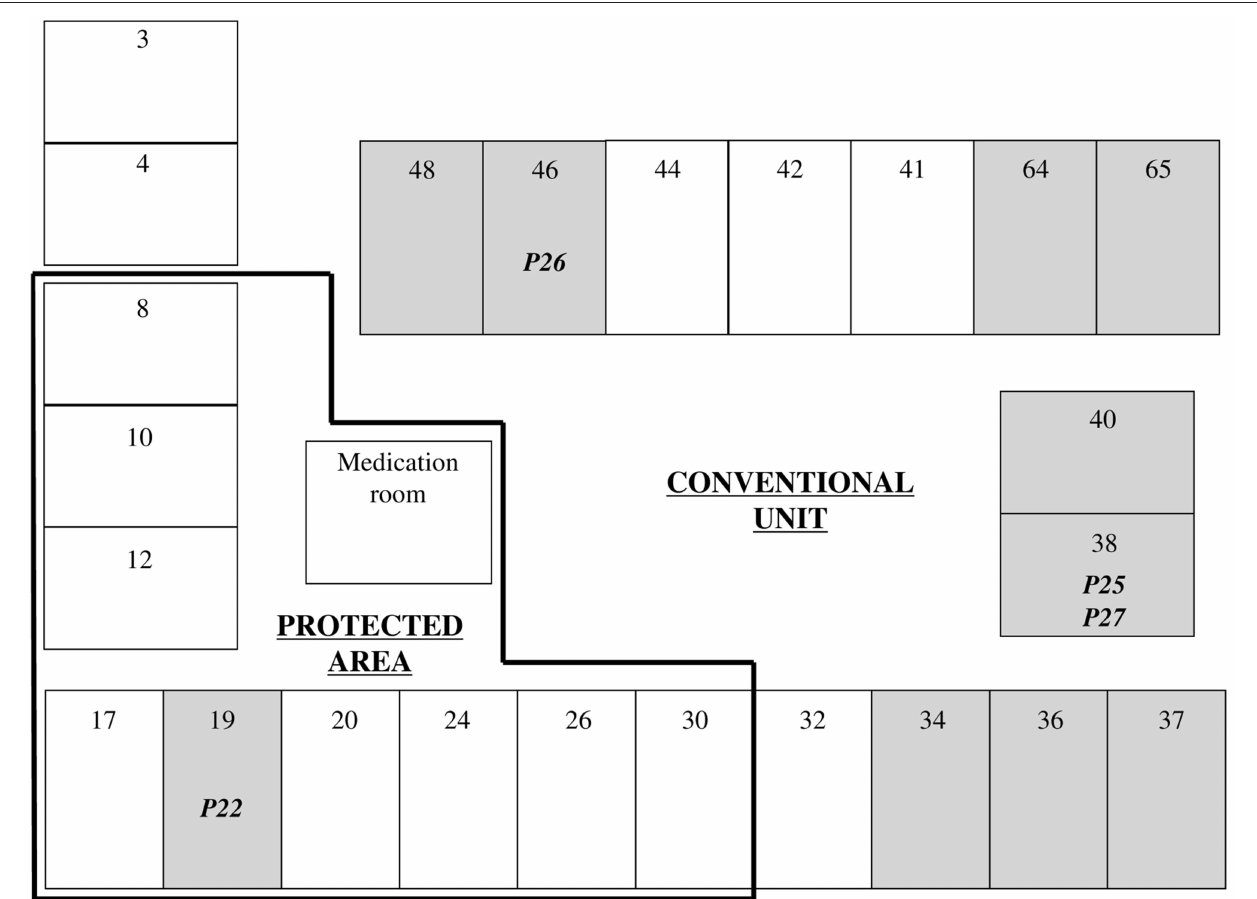
FIGURE 2 | Plan of the Hematology ward. Numbers indicate room numbers. ESBL-producing E. cloacae were isolated from samples collected in gray rooms. Patient number contaminated by sink is indicated in the occurring room.